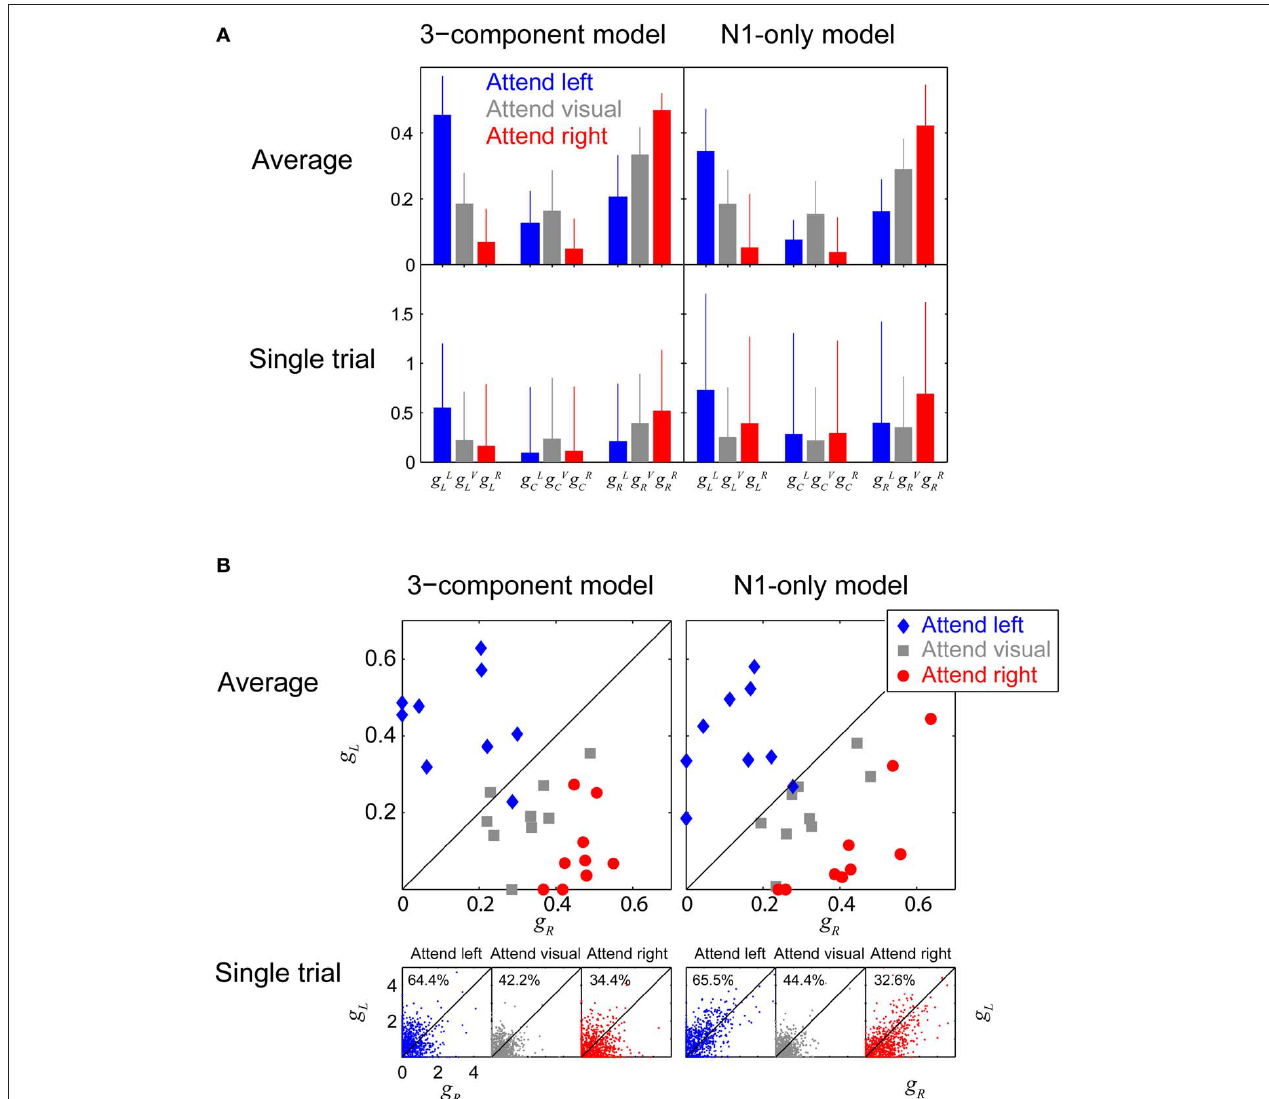
FIGURE 8 | Attentional gains. (A) Attentional gains fit to Fz responses, obtained from both individual-subject average ERPs (top row), and single trials (bottom row). Left panels show gains fit using the 3-component model; right panels show gains fit using the N1-only model. The median values across subjects are plotted, with error-bars showing the root-mean-squared deviation from the medians. Blue, red, and gray bars represent attend-left, attend-right, and attend-visual conditions, respectively. Each triplet of adjacent bars shows the gains for one of the auditory streams (left, center, and right, going from left to right in a given panel). The gain to a given stream is